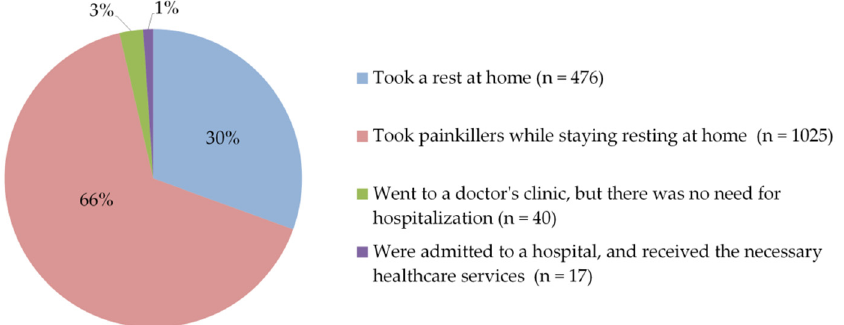
Figure 9. Participants’ acts to relieve post-vaccination side effects.